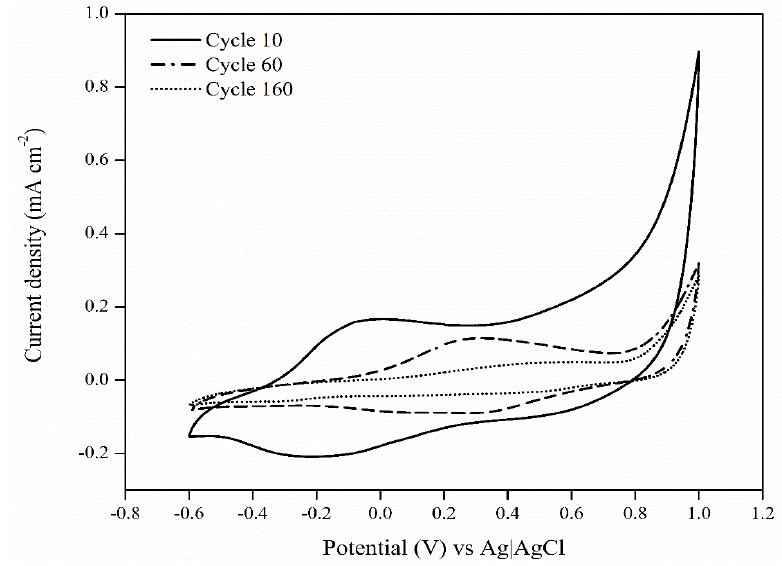
Figure 4. Cyclic voltammograms for the PEDOT: κ C:Dx recorded at 25 mV · s − 1 after 10, 60, and 160 cycles of electrical stimulation in ammonium acetate 0.10 M.